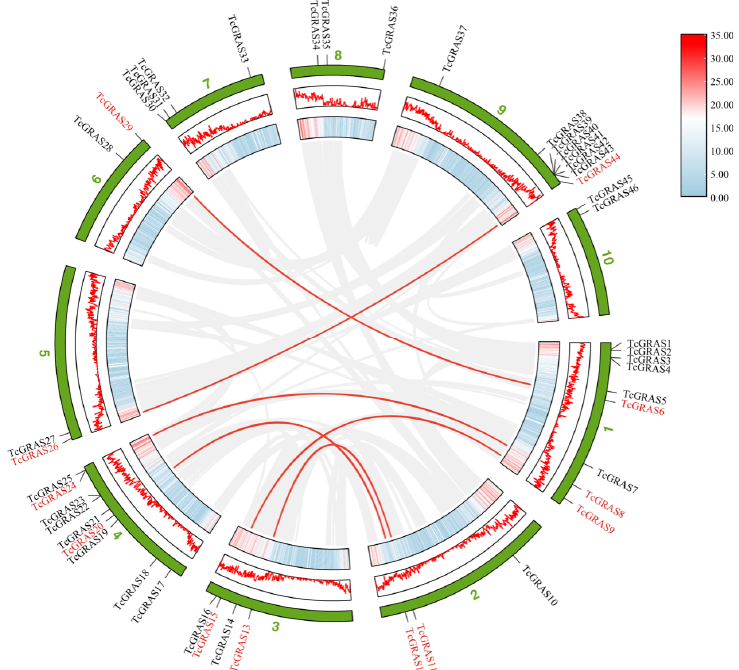
Figure 4. Schematic diagram of the duplication patterns of the TcGRAS genes. The red lines show segmental duplications of TcGRAS gene pairs. The gray lines show segmental duplications of all gene pairs in the T.cacao genome. The first ring from outside indicates the chromosomal localization of 46 putative GRAS genes in T.cacao . The second and third rings from outside represent the density of genes on the chromosomes. The blue-to-red scale bar on the right indicates the number of SNPs within 1 Mb window size.